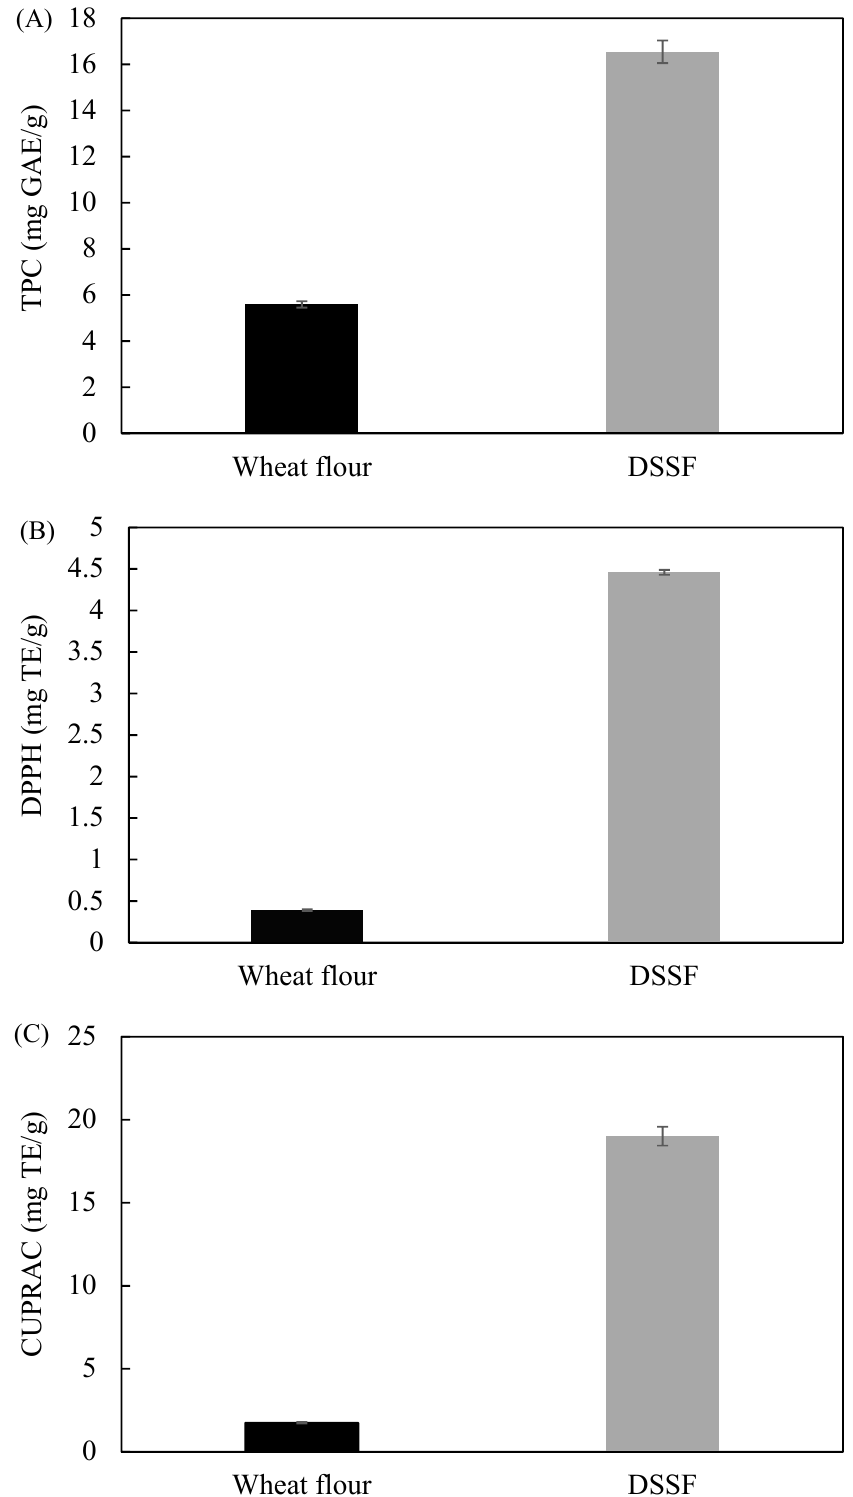
Figure 1. Total phenolic content (TPC) ( A ) 2,2-Diphenyl-1-picrylhydrazyl (DPPH) ( B ) and cupric reducing antioxidant capacity (CUPRAC) ( C ) values of wheat flour and defatted sunflower seed flour (DSSF). Data are expressed as means ± SD ( n = 3).